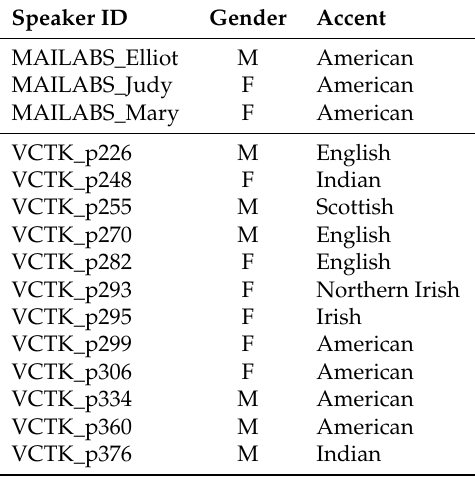
Table 1. M-AILABS US and VCTK speaker